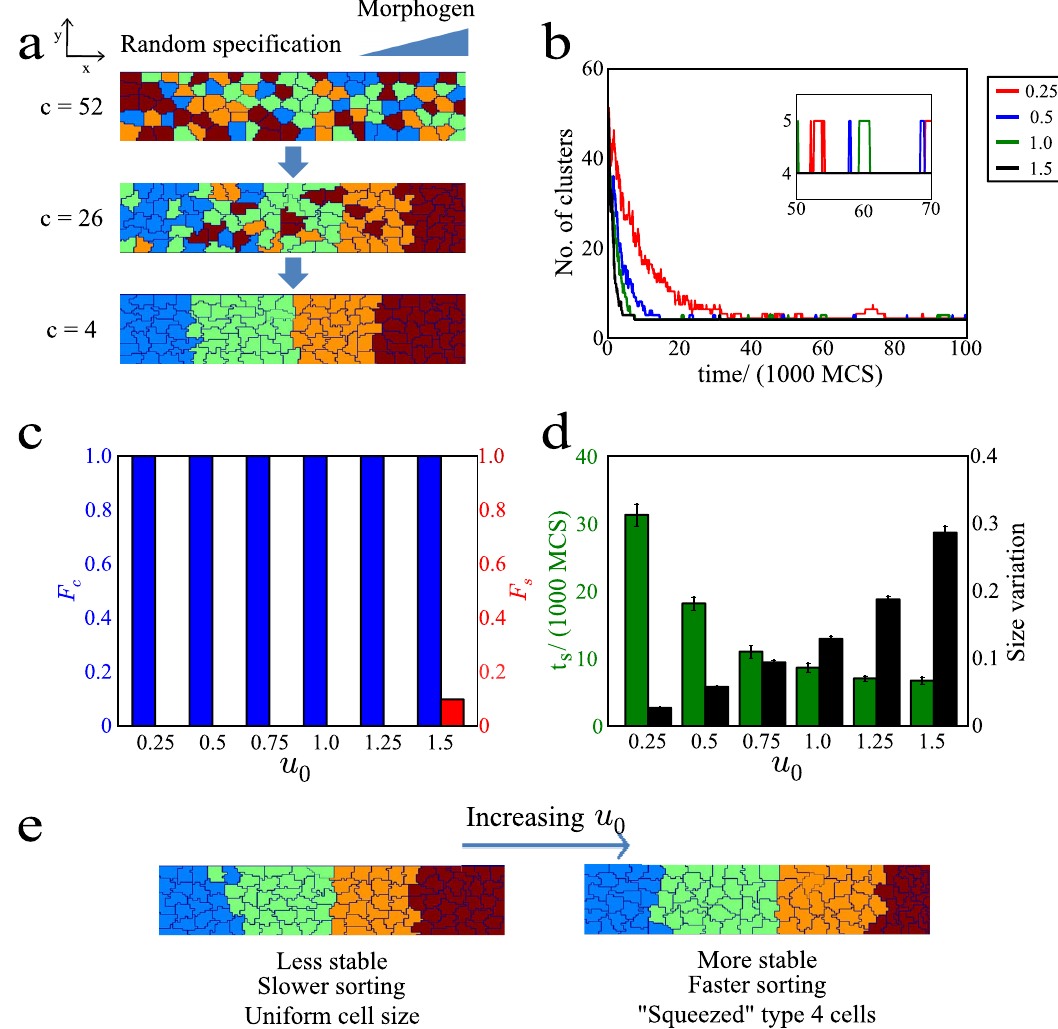
Figure 1. Chemotaxis model leads to high fraction of correct sorting but low level of stable sorting. 10 runs were performed for each value of m o . ( a ) The cell grid at start (top), middle (middle) and end of a run (last). The number of clusters, c , is shown to the left of the grid. Cell boundaries are in dark blue. The morphogen source is located along the rightmost lattice points ( x = 142) and diffuses to form a gradient in the x -th (horizontal) direction. The different cell types are colored in light blue (type 1), green (type 2), orange (type 3) and red (type 4). ( b ) Plot of number of clusters with time for different values of magnitude of chemotactic strength, m o . The number of clusters decreases steadily with time. (Inset) Zoom-in plot of number of clusters between t = 50,000 and 70,000 MCS. ( c ) Bar graphs of fraction of correct and stable sorting, F c (blue) and F s (red), respectively, for different values of m o . For m o , 1.5, none of the runs led to stable sorting. ( d ) Bar graphs for sorting time, t s , (green) and size variation (black) for different values of m o . Error bars show the standard errors. ( e ) Summary of findings for low and high m o .